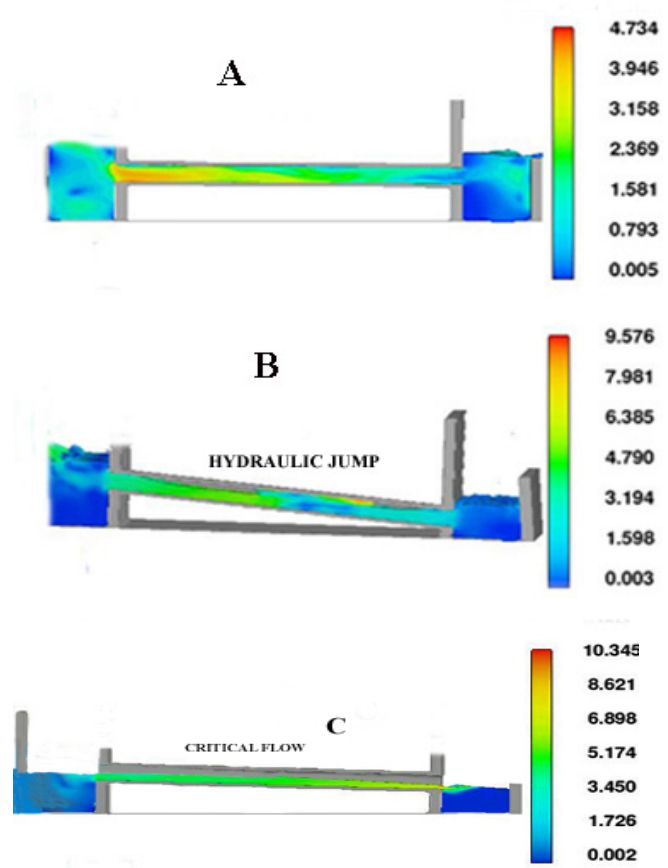
Figure 10. FLOW-3D CFD calculation results for pipeline Cases ( A – C ). Velocity in m/s.